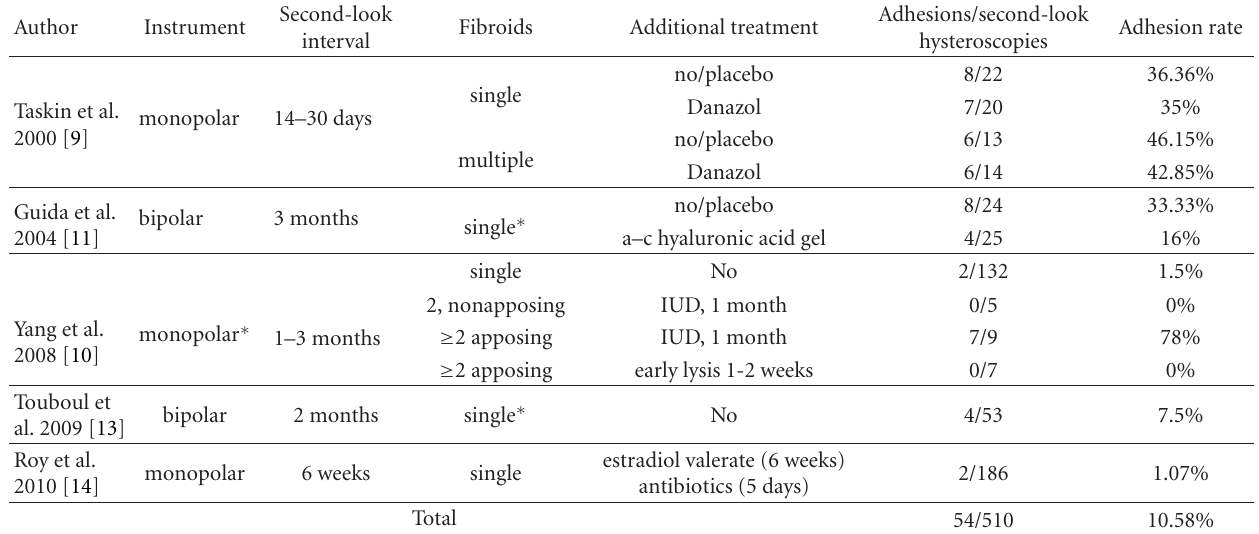
Table 1: Intrauterine synechiae following resectoscopic myomectomy. Second-look